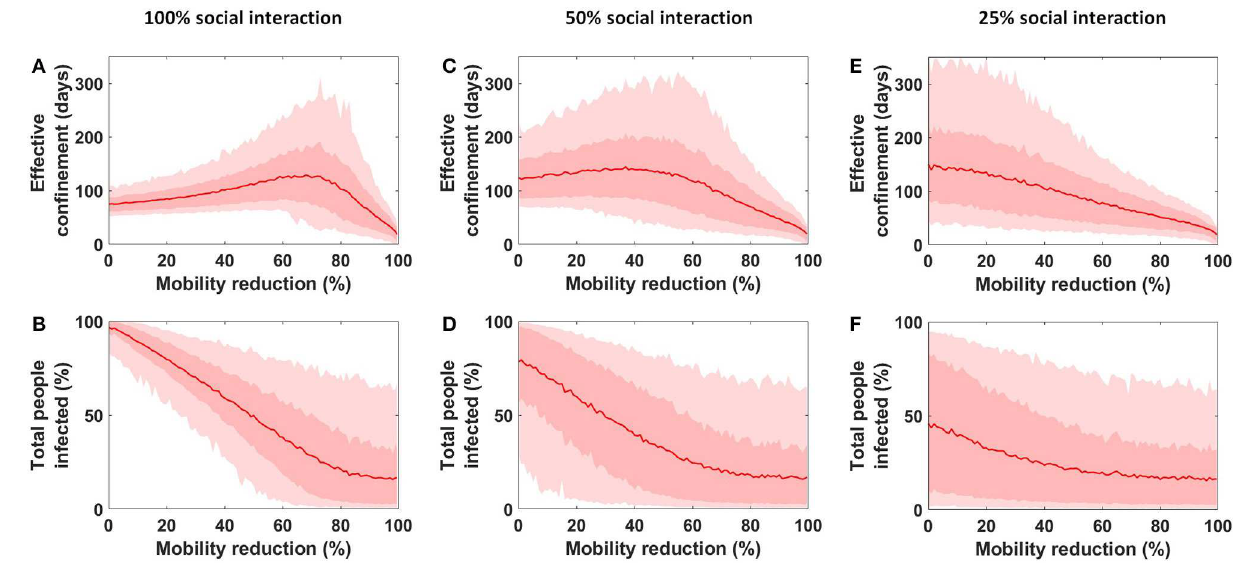
FIGURE 2 | Effective days of confinement and total (detected and undetected) people infected as a function of the mobility reduction (i.e., ratio of individuals confined). (A,B) Scenario in which social interactions do not decrease once confinement is decreed (i.e., no social distancing is applied). (C,D) Scenario in which social interactions (i.e., the probability of infection P inf ) reduce by 50% once confinement is decreed. (E,F) Scenario in which social interactions reduce by 75% once confinement is decreed. The red line is the mean value obtain from 1,000 Monte Carlo simulations, the dark red area represents the 1-sigma confidence interval, and the light red area represents the 2-sigma confidence interval. For the parameters of the model, we use: number of individuals, N = 11,000; radius of influence, r inf = 4 m ; and duration of free spread of the outbreak, τ free = 21 days. The duration of viral shedding is chosen randomly in the range τ shed = 8 − 37 days; and initial probability of infection, P inf , and probability of not detecting infected individuals, P und , are chosen randomly between 50 and 100%. Only combinations of the parameters providing exponential growth rates at the beginning of the outbreak in the range 0.2–0.4 day − 1 are accepted. These simulations are for the case of New York